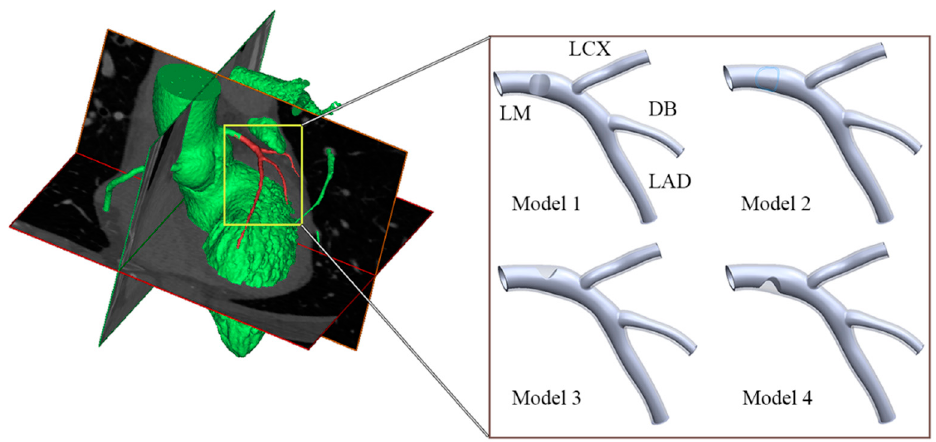
Figure 1. The location of the plaque in the left coronary artery (Model 1: the plaque is located on the side away from the heart; Model 2: the plaque is located on the side close to the heart; Model 3: the plaque is located on the side close to LCX; and Model 4: the plaque is located on the side away from LCX).